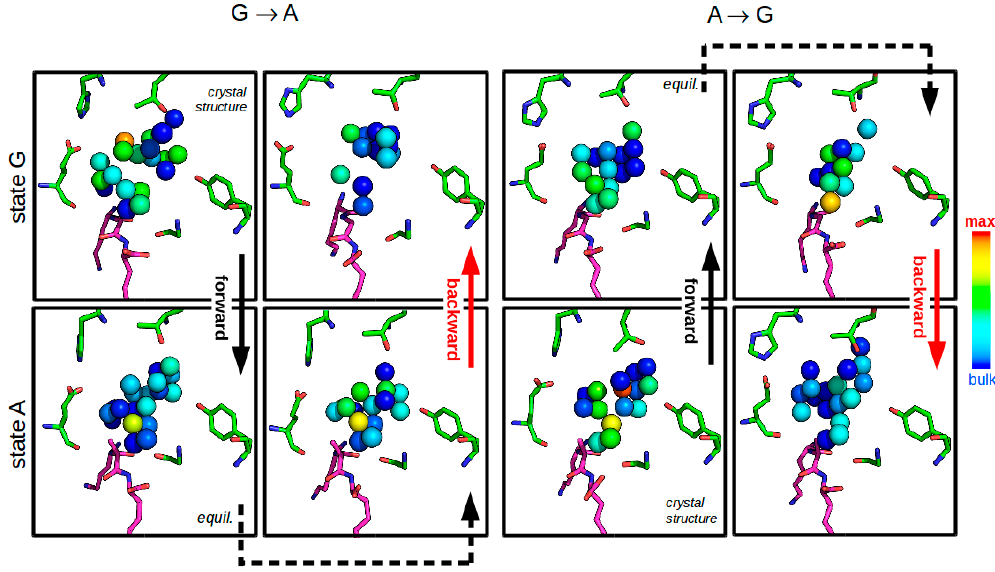
Figure 8. Depiction of average water occurrences over the 10 ns end-point TI simulations of transformations between KGK and KAK. Protein and ligand atoms are depicted at their average positions after a superposition based on the backbone atoms. The average water occurrence frequency was monitored on a grid with a spacing of 0.2 nm. Water molecules are assigned to their nearest grid point. Grid points with at least 30% occupancy of the highest observed occupancy (corresponding to bulk water) are indicated in the figure and colored accordingly (red ~90%; green ~50%; dark blue ~30%). For clarity, some water locations close to the lysine-1 and lysine-3 side chains of the ligand have been removed. Panels in the same row represent identical system states. Note the lowered water densities when comparing the first and the last panel of each transformation run (upper left two for KGK crystal → KGK final , lower right two for KAK crystal → KAK final ).